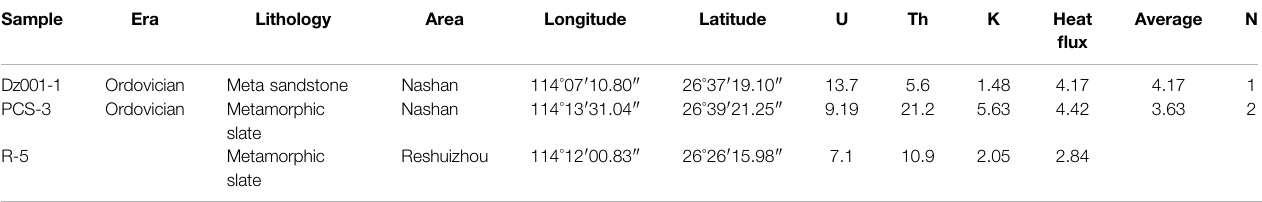
TABLE 6 | Heat production of rocks in the study area.